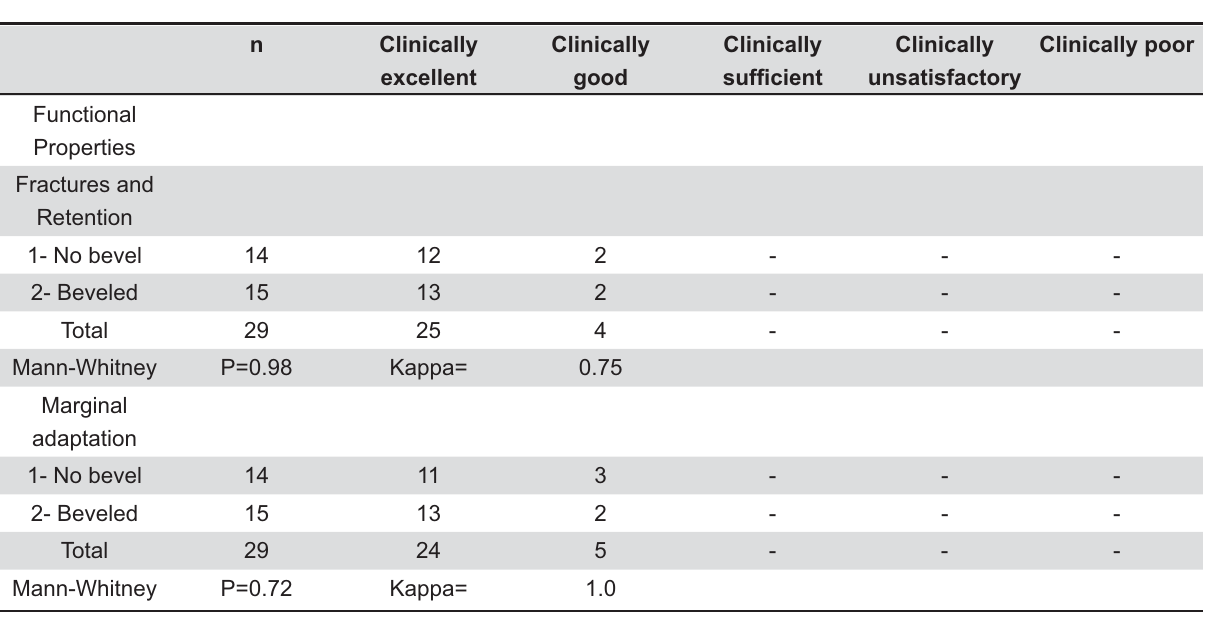
Table 2- One-year clinical evaluation of restorations: functional properties